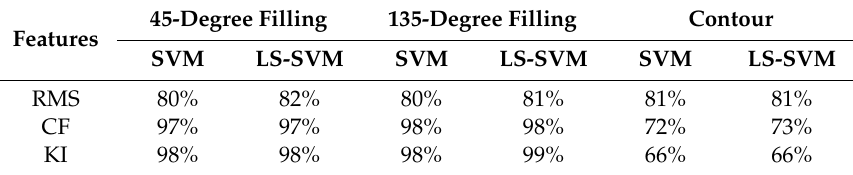
Table 3. The results of state identification using SVM and LS-SVM for training